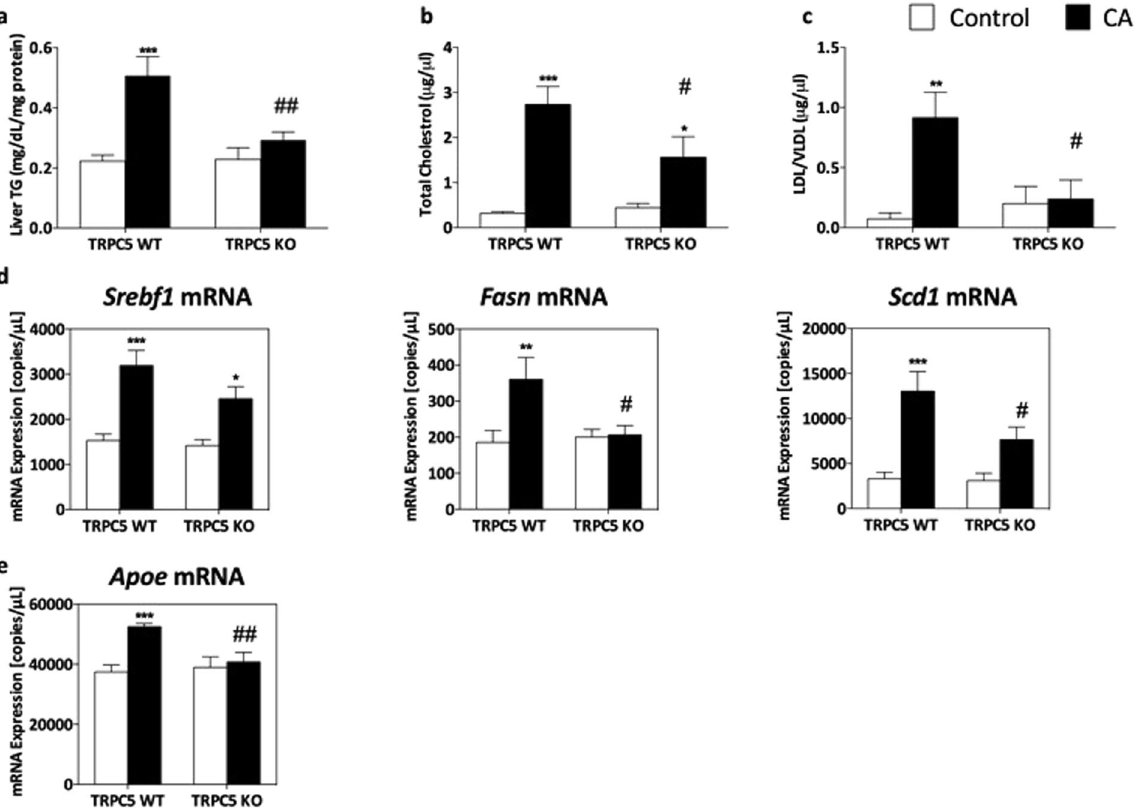
Figure 3. Cholestasis-induced hepatic dyslipidaemia is attenuated in TRPC5 KO mice. WT and TRPC5 KO mice were fed control (RM3) or CA (0.5% cholic acid supplemented RM3 diet) for 21 days, and ( a ) liver triglyceride (TG), total cholesterol ( b ), and LDL/VLDL ( c ) concentrations were measured. Hepatic gene expression determined by real-time quantitative PCR of genes involved in lipid biosynthesis ( d ), sterol regulatory element-binding transcription factor 1 (Srebf1), fatty acid synthase (Fasn), stearoyl-Coenzyme A desaturase 1 (Scd1) and ( e ) apolipoprotein E (Apoe), normalized to HPRT, β -actin, and B 2 M. Results are mean ± S.E.M., n = 6–7. * P < 0.05, *** P < 0.001 vs control; # P < 0.05 vs WT CA as determined by two-way ANOVA and Bonferronni Post Hoc